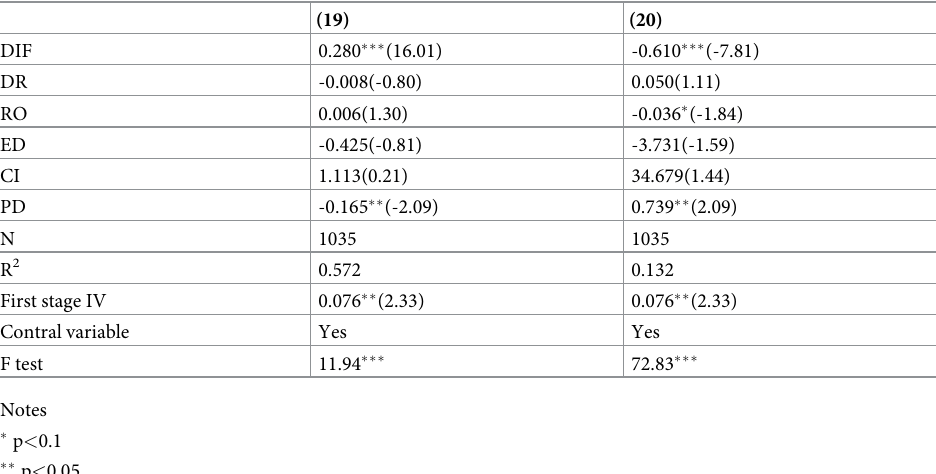
Table 6. Estimation results of instrumental variable